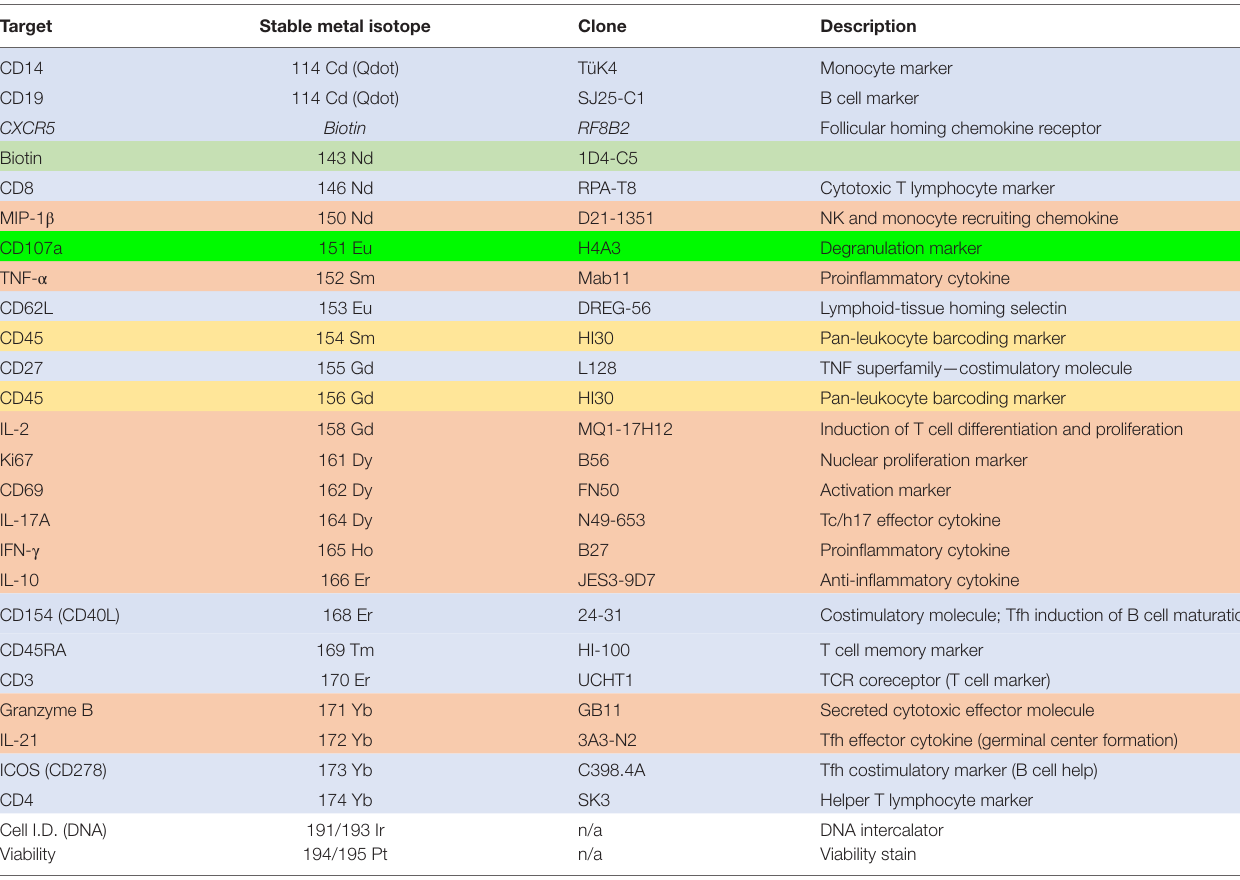
Primary surface antibodies are filled with blue, secondary surface antibodies with green, and intracellular antibodies with orange. Barcoding antibodies are shaded in yellow, and anti- CD107a, which is added during stimulation to best account for the active cycling between the surface and intracellular vesicles, is highlighted in